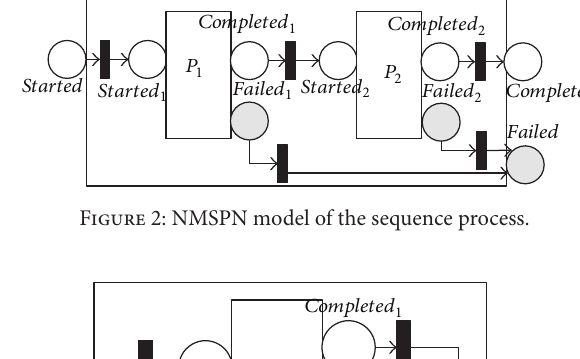
Figure 2: NMSPN model of the sequence process.